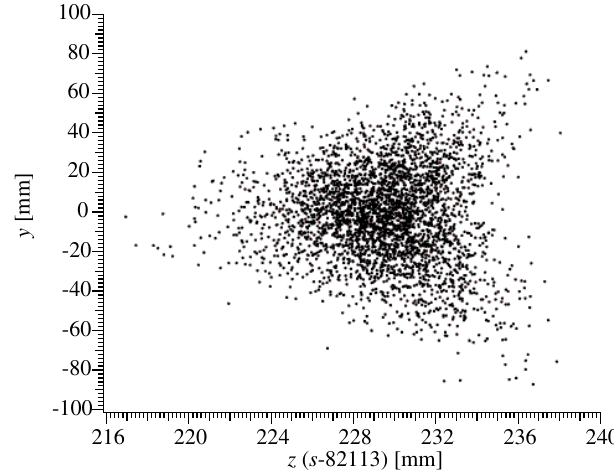
FIG. 12. Stripped electron distribution in the y - z plane at x (cid:4) (cid:5) 320 mm (4000 particles).